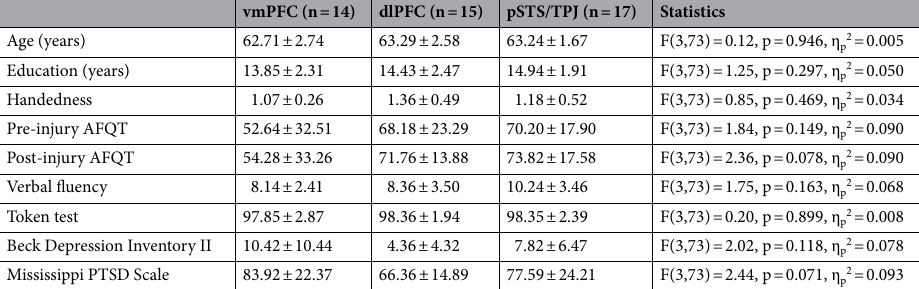
Table 2. Description of demographic characteristics and neuropsychological tests [mean ± SD], and ANOVA test statistics for pTBI patients in lesion subgroups and HCs a ( a For HCs scores, see Table 1). vmPFC ventromedial prefrontal cortex, dlPFC dorsolateral prefrontal cortex, pSTS/TPJ posterior superior temporal sulcus/temporo-parietal